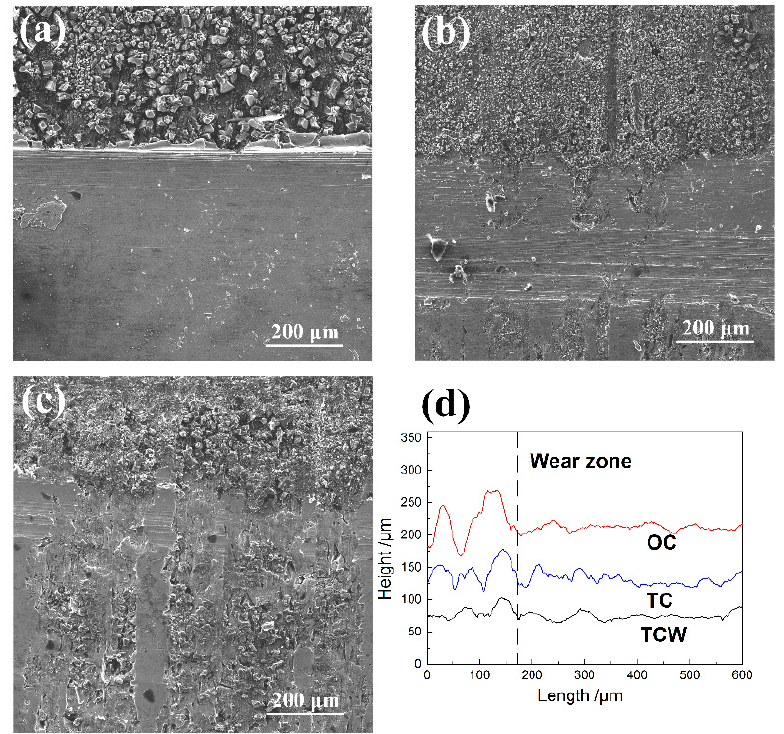
Figure 4. Morphologies and profiles of the piston ring samples; ( a ) the surface morphologies of the piston ring corresponding to the OC sample, ( b ) the surface morphologies of the piston ring corresponding to the TC sample, ( c ) the surface morphologies of the piston ring corresponding to the TCW sample, ( d ) the profiles of the worn surface of the piston ring samples.